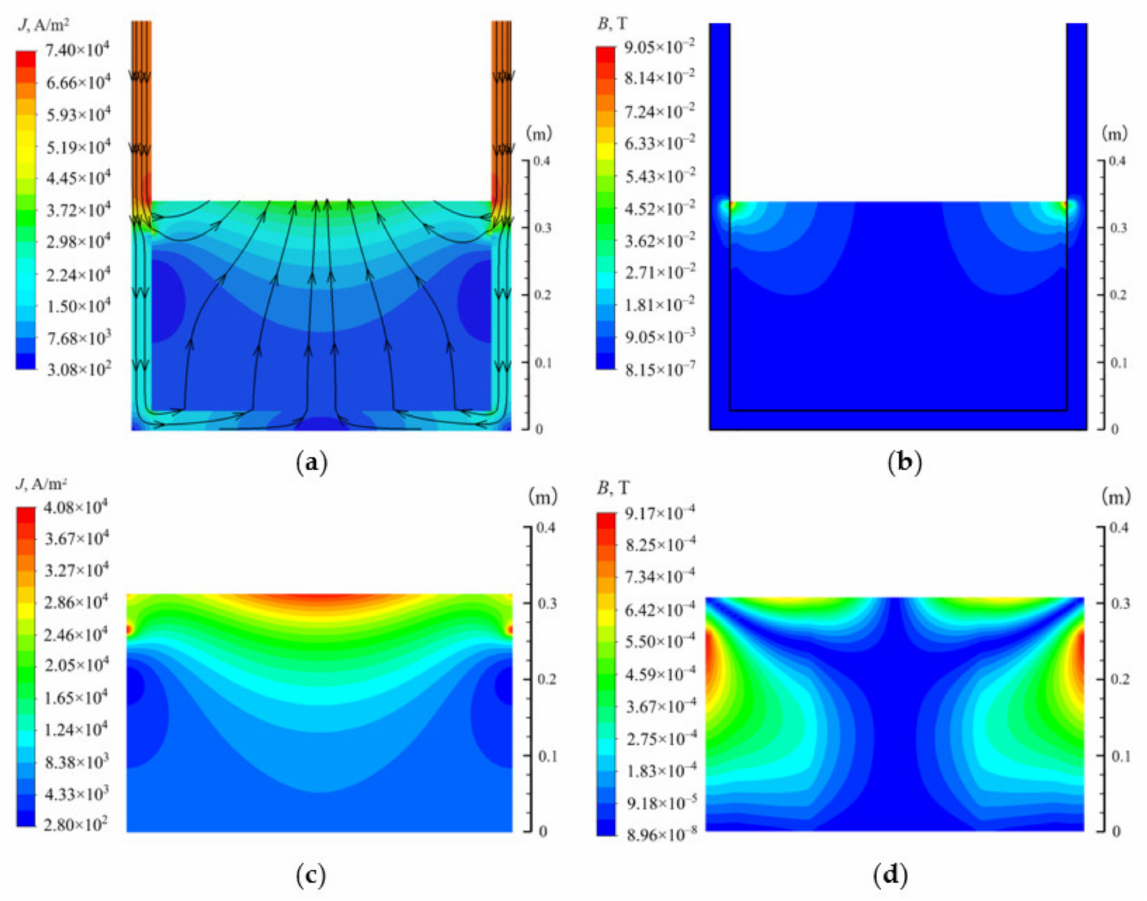
Figure 7. The distribution of the electromagnetic field inside the ingot: ( a ) current density using actual boundary; ( b ) magnetic induction intensity using actual boundary; ( c ) current density using simplified boundary; ( d ) magnetic induction intensity using simplified